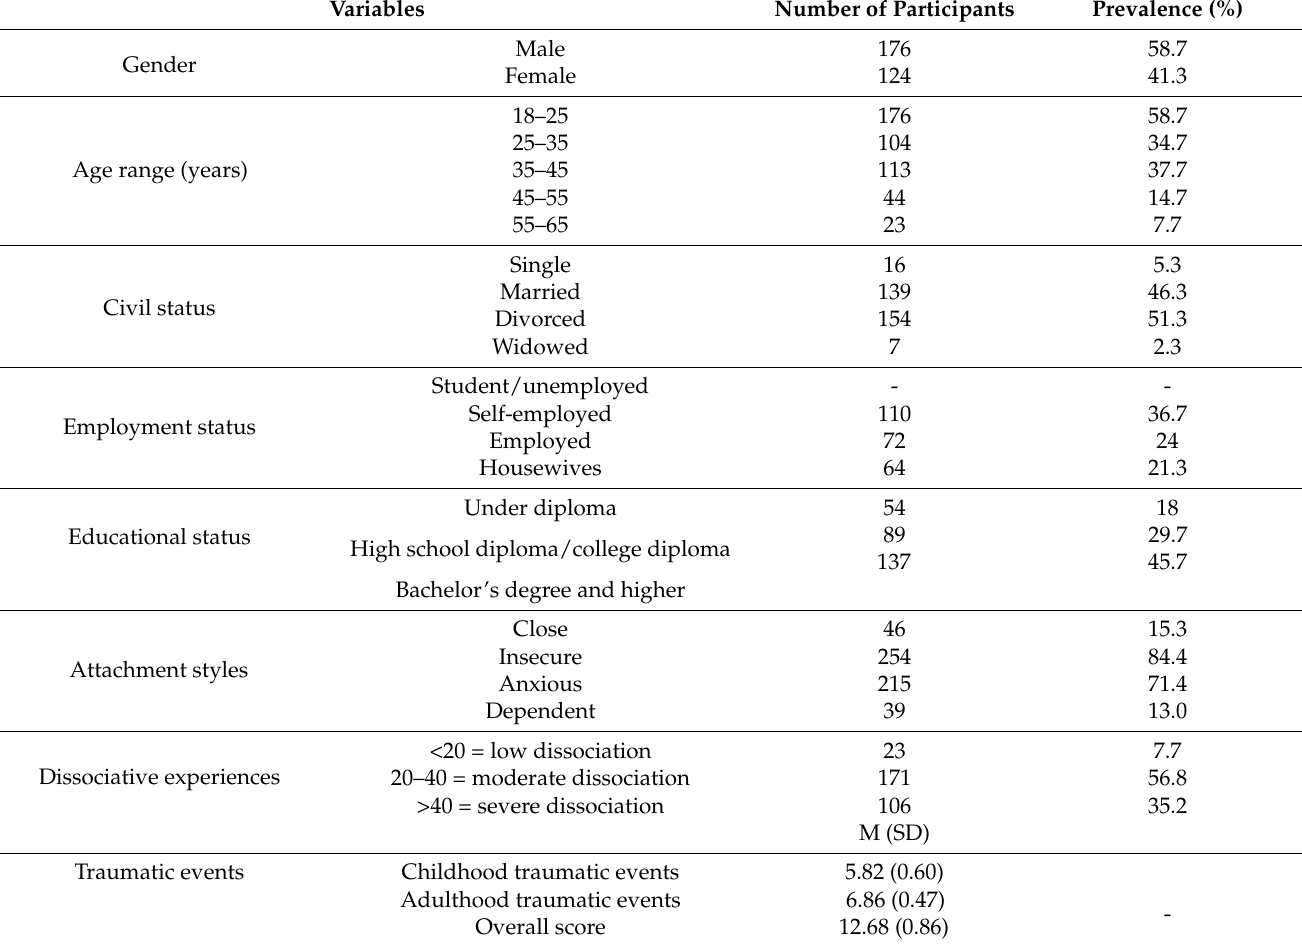
Table 1. Frequency of sociodemographic dimensions, attachment styles, and categories of